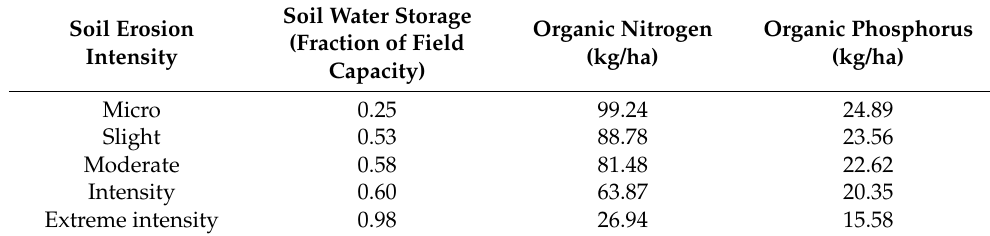
Table 4. Environment parameters in the EPIC model.